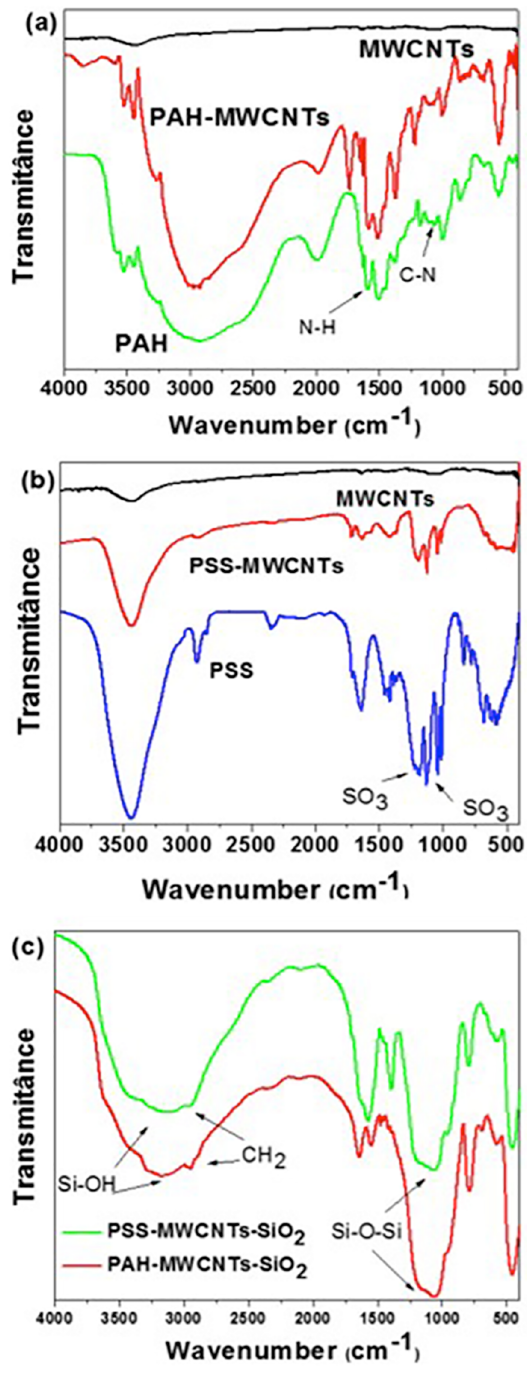
Figure 6. FTIR spectra of (a) MWCNTs, PAH and PAH-MWCNTs, (b) MWCNTs, PSS and PSS-MWCNTs and (c) PAH-MWCNTs- SiO and PSS-MWCNTs-SiO 2 2